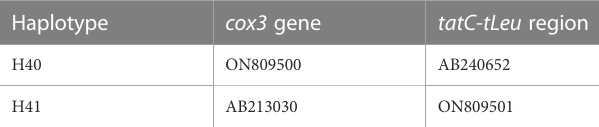
TABLE 2 Novel haplotypes of the combined sequences of cox3 and tatC - tLeu detected in Chinese native populations of Undaria pinnati fi da and the corresponding combination of the accession numbers.